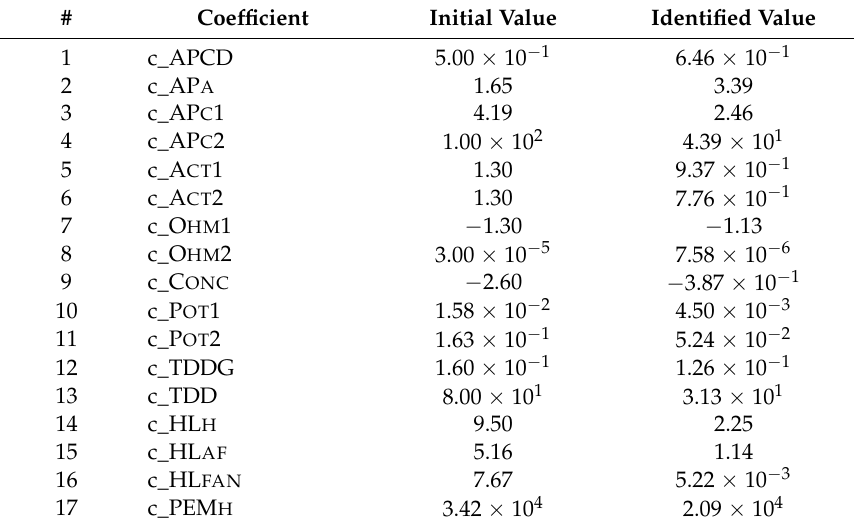
Table 3. Initial and identified